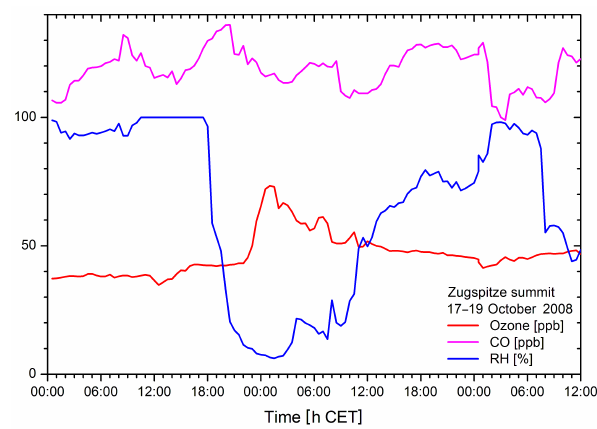
Figure 11. Zugspitze in situ measurements of ozone, carbon monoxide and relative humidity on 17–19 October 2008; the strato- spheric layer is clearly visible in the H 2 O and O 3 data, but there is no significant hint in the CO